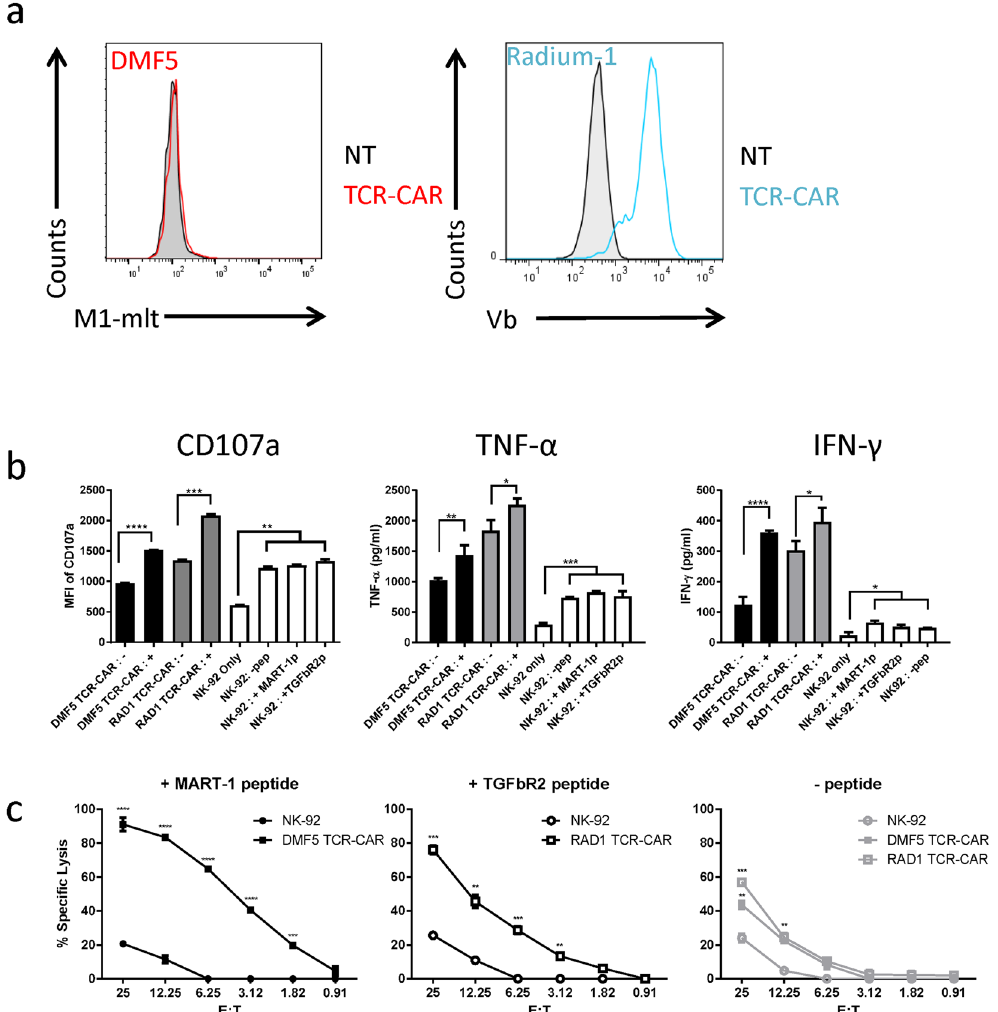
Figure 4. TCR-CAR can redirect NK-92 cells. ( a ) NK-92 cells were non transfected (grey) or transfected with DMF5 TCR-CAR (red), Radium-1 (blue) and stained with specific antibody or multimer, respectively. Shown is a single staining representative of two separate stainings. ( b ) Stimulation of plain NK-92 cells (white) or transfected with TCR-CAR constructs (DMF5, black and Radium-1, grey) with Granta-519 loaded ( + ) or not ( − ) with the cognate peptide was performed for 6 hours at a E:T ratio of 1:2. Presence of CD107a was detected by flow cytometry and the MFI of the signal was plotted. Mean ± SEM, N = 3. Unpaired t-test was used as statistical analysis between indicated groups and similar trends were depicted as a group. For cytokines analysis, NK-92 cells transduced (black and grey) or not (white) were co-cultured with target cells loaded ( + ) or not ( − ) with the cognate peptide at 1:2 E:T ratio for 24 hours. Non transfected NK-92 cells alone (NK-92 only) were also tested. Supernatants from each condition were collected and presence of TNF- α and IFN- γ was performed with the Bio-Rad Bio-Plex 100 system. Measurements were made in triplicate from three separate supernatants per condition. Cytokine concentrations are shown in picograms per milliliter (pg/mL). Mean ± SEM, N = 3. Unpaired t-test was used as statistical analysis between indicated groups and similar trends were depicted as a group. ( c ) Specific lysis of target cells loaded with the indicated peptide (MART-1 peptide, black, TGFbR2 peptide, white, no peptide, grey) by plain NK-92 (circles) or NK-92 expressing TCR-CAR (squares) at different E:T ratios in a BLI cytotoxic assay. The specific lysis luminescence readings were collected after 10 hours of co-culture. Mean ± SEM, N = 3. Unpaired t-test performed between indicated group and corresponding non-transduced NK-92 group. Ranges for unpaired t-test were as follows * P < 0.05, ** P < 0.01, *** P < 0.001, **** P <